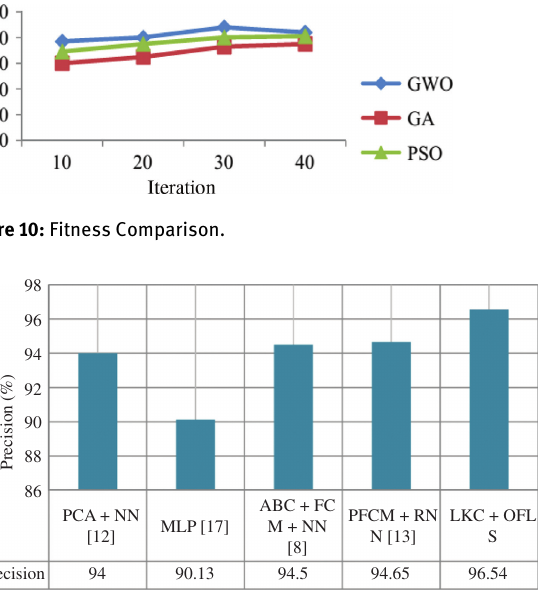
Figure 11: Comparative Analysis Based on the Precision Measure for KDD CUP99 Dataset.